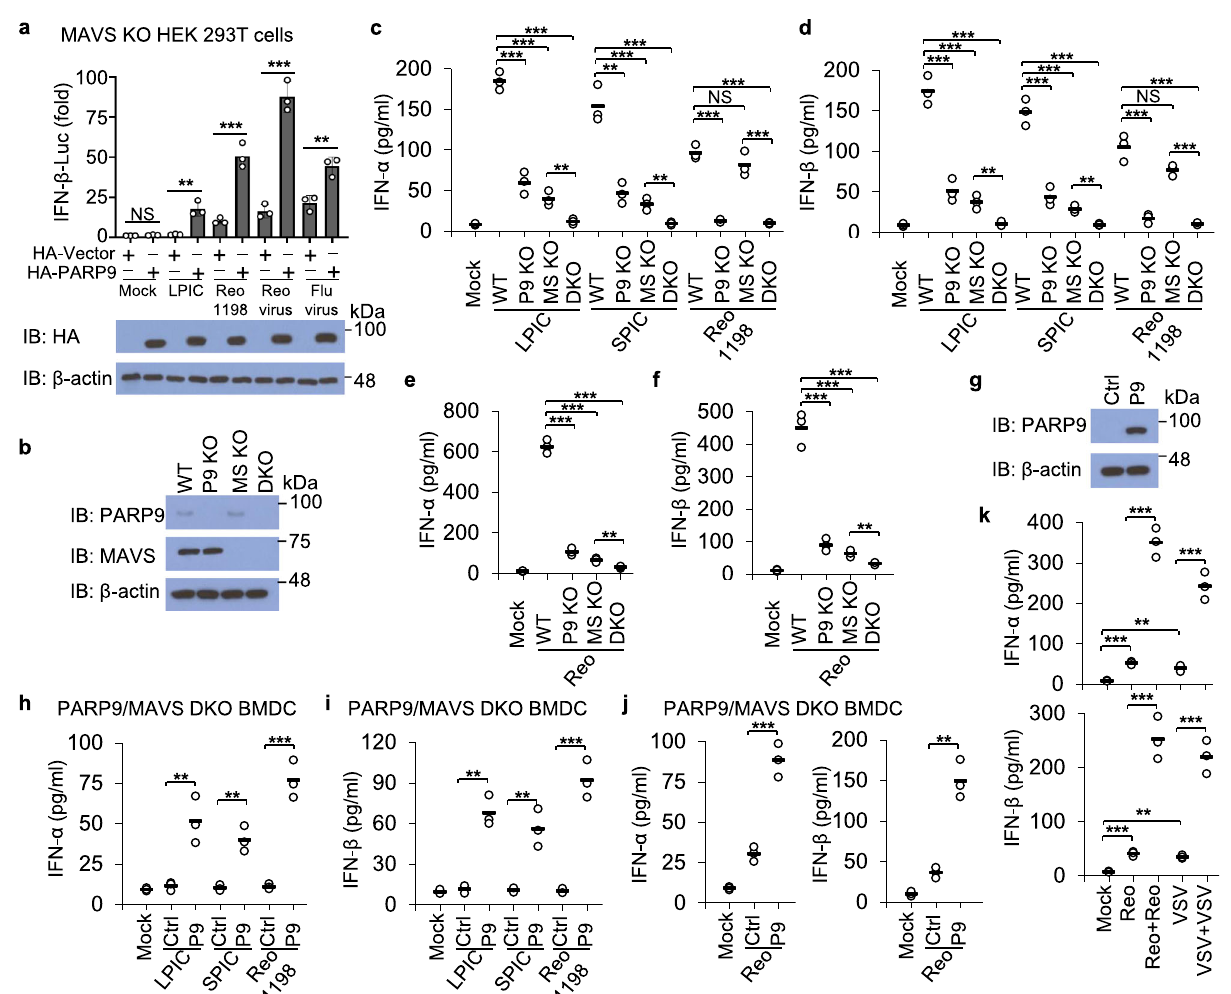
Fig. 5 PARP9 initiates MAVS-independent production of type I IFN. a IFN- β -Luciferase reporter assays and immunoblot (IB) analysis of HA-tagged PARP9 expression in MAVS knockout (KO) HEK 293 T cells transfected with IFN- β -Luc reporter plasmid, plus HA vector or HA-PARP9 plasmid for 12 h, followed by 10 h of stimulation without (Mock) or with long poly I:C (LPIC, 0.5 μ g/ml) and viral dsRNA Reo1198 (Reo1198, 0.5 μ g/ml) delivered by Lipofectamine 3000 or infection with reovirus or in fl uenza (Flu) virus at MOI of 5 ( n = 3 per group). Results are presented relative to those from unstimulated cells, set as 1. Error bars indicate standard error of the mean. b Immunoblot analysis of PARP9 or MAVS in mouse BDMC from wild-type (WT), PARP9 knockout (P9 KO), MAVS knockout (MS KO), and PARP9/MAVS double knockout (DKO) mice. ELISA of IFN- α ( c ) and IFN- β ( d ) production in mouse BDMC from wild-type (WT), PARP9 knockout (P9 KO), MAVS knockout (MS KO), and PARP9/MAVS double knockout (DKO) mice after 10 h of stimulation with long poly I:C (LPIC, 0.5 μ g/ml), short poly I:C (SPIC, 0.5 μ g/ml) or viral dsRNA Reo1198 (Reo1198, 1 μ g/ml) delivered by Lipofectamine 3000 ( n = 3 per group). ELISA of IFN- α ( e ) and IFN- β ( f ) production in mouse BDMC from WT, P9 KO, MS KO, and DKO mice after 12 h of infection with reovirus at MOI of 5 ( n = 3 per group). g Immunoblot analysis of PARP9 expression in PARP9/MAVS double knockout (DKO) BMDC reconstituted with control vector (Ctrl) or wild-type PARP9 (P9). ELISA of IFN- α ( h ) and IFN- β ( i ) production by DKO BMDC reconstituted with control vector (Ctrl) or wild- type PARP9 (P9) after 10 h of stimulation with long poly I:C (LPIC, 0.5 μ g/ml), short poly I:C (SPIC, 0.5 μ g/ml), or viral dsRNA Reo1198 (Reo1198, 1 μ g/ml) delivered by Lipofectamine 3000 ( n = 3 per group). j ELISA of IFN- α and IFN- β production by DKO BMDC reconstituted with control vector (Ctrl) or wild- type PARP9 (P9) after 12 h of infection with reovirus at MOI of 5 ( n = 3 per group). k ELISA of IFN- α and IFN- β production by MAVS KO BMDC after 6 h of fi rst infection with reovirus, VSV at MOI of 5 or rechallenge with reovirus and VSV for another 6 h after fi rst infection (n = 3 per group). Each circle represents an individual independent experiment and small solid black lines indicate the average of triplicates for results in c – f and h – k . NS, not signi fi cant ( p > 0.05), ** p < 0.01, *** p < 0.001, and p value was calculated by unpaired two-tailed Student ’ s t test. Mock, BMDC without stimulation or infection. Data are representative of three independent experiments. Exact p values ( a , p = 0.057, p = 0.0037, p = 0.00085, p = 0.00029, p = 0.0062; c , p = 0.0003, p = 0.00006, p = 0.00001, p = 0.0071, p = 0.0021, p = 0.00099, p = 0.0004, p = 0.0058, p = 0.00008, p = 0.057, p = 0.00007, p = 0.0004; d , p = 0.0007, p = 0.0003, p = 0.0001, p = 0.0074, p = 0.0008, p = 0.0003, p = 0.0001, p = 0.0017, p = 0.0009, p = 0.052, p = 0.0006, p = 0.0001; e p = 0.00002, p = 0.00001, p < 0.00001, p = 0.0071; f p = 0.0004, p = 0.0002, p = 0.0002, p = 0.0078; h , p = 0.0095, p = 0.0031, p = 0.00063; i p = 0.0011, p = 0.005, p = 0.00054; j , left, p = 0.00087, right, p = 0.0013; k upper, p = 0.00014, p = 0.0023, p = 0.0005, p = 0.0005, lower, p = 0.0008, p = 0.0015, p = 0.0005, p =